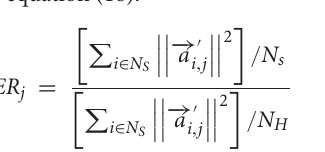
FIGURE 11 | (A) Scree plot indicating the cumulative explained variance ratio for the singular value spectrum. The five most important modes for LDA projection are colored using red circles. (B) Two-dimensional illustration of LDA projection for a sample dataset using the optimal projection vector for the first 20 PCA modes and the five most important LDA modes colored in